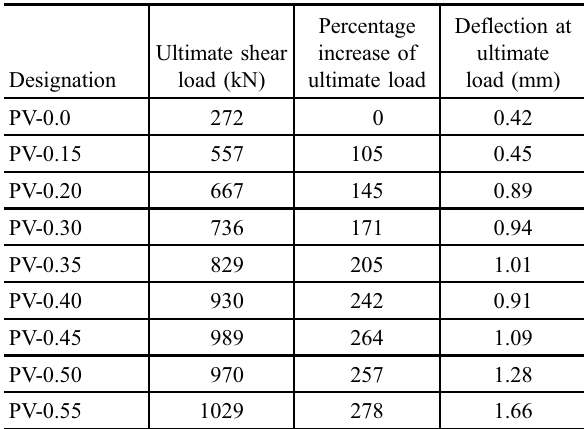
Fig. 9. Load – de fl ection curves series PH Table 2. Corbel series